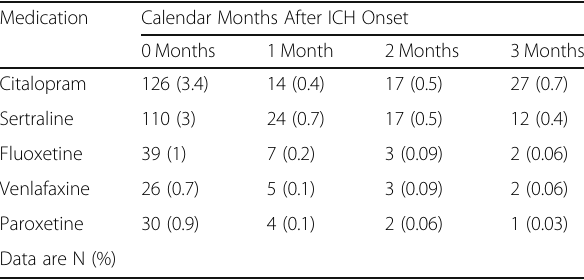
Table 3 Anti-depressant medication administration in the Multi- Center cohort. Only medications found in at least 0.5% of the cohort are shown (see